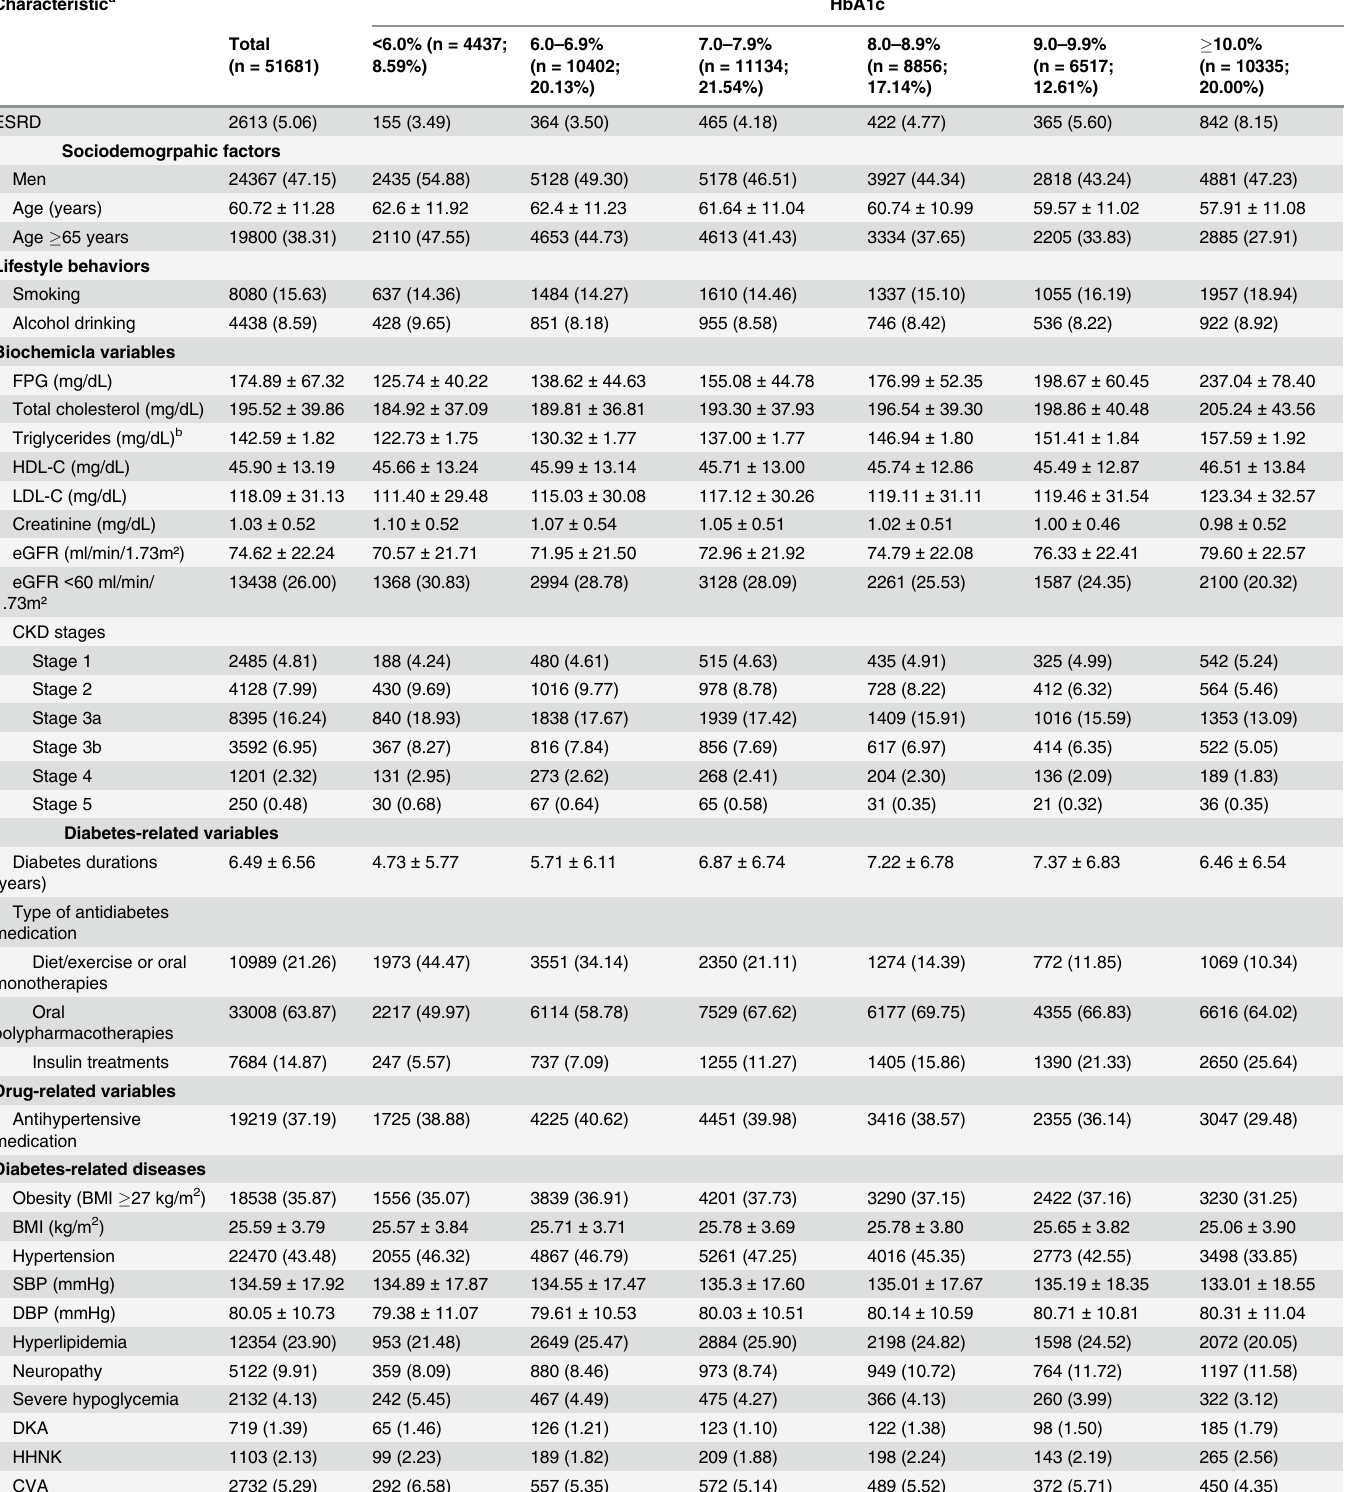
Table 1. Characteristics of study subjects stratified by HbA1c